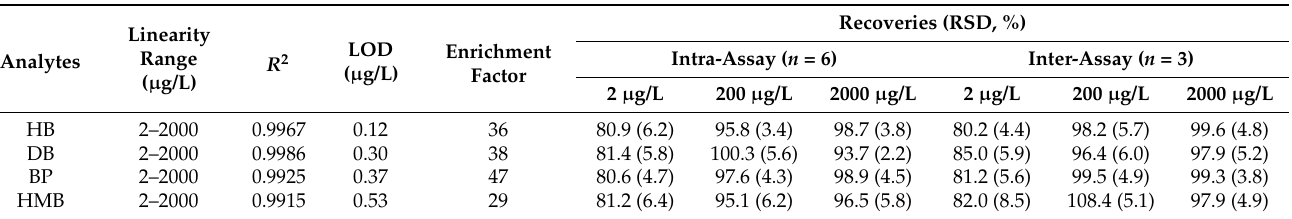
Table 2. Linearity range, correlation coefficient, limit of detection, enrichment multiple, accuracy, and precision (RSD) of the developed method.